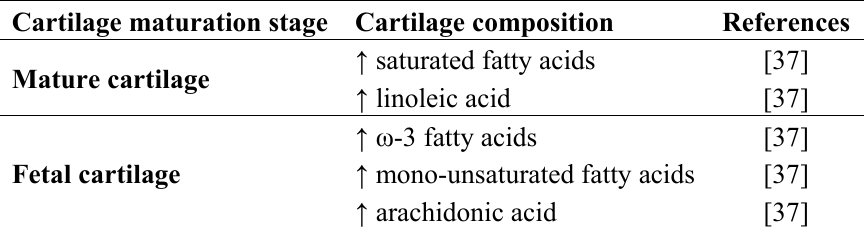
Table 2. Fatty acid composition in normal